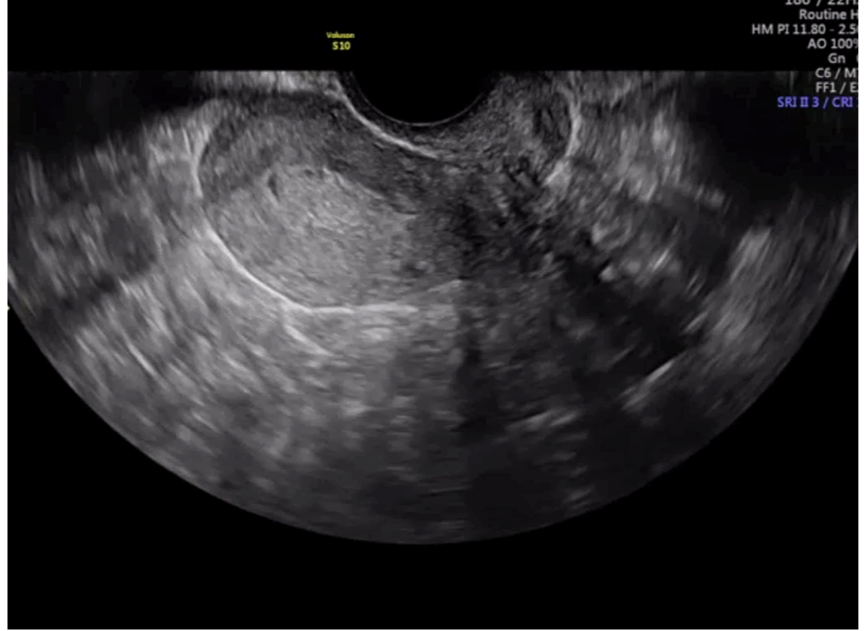
Figure 3. Transvaginal ultrasound showing a case of superficial infiltration in endometrial cancer according to subjective impression.